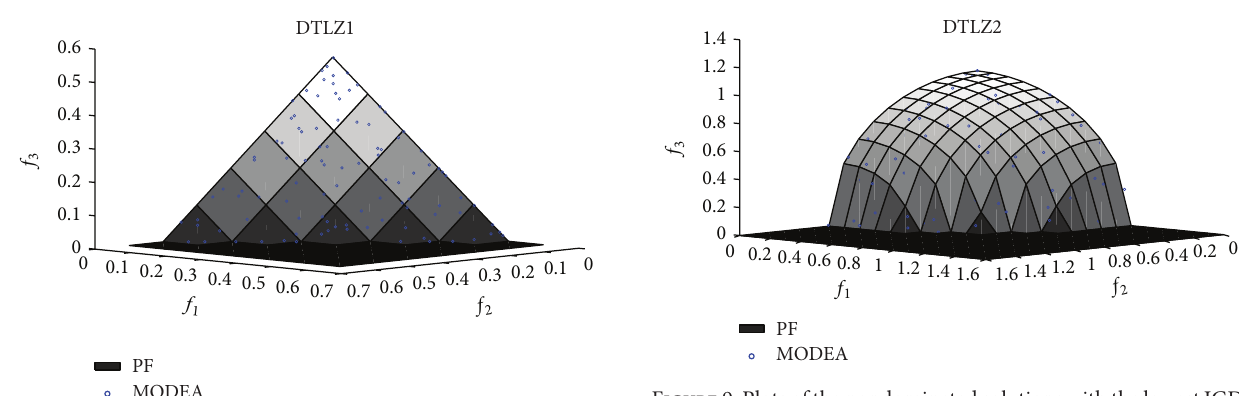
Figure 9: Plots of the nondominated solutions with the lowest IGD- metric values found by MODEA in 10 runs in the objective space on DTLZ2 where 𝑁 = 100 and 𝑇 = 250 .